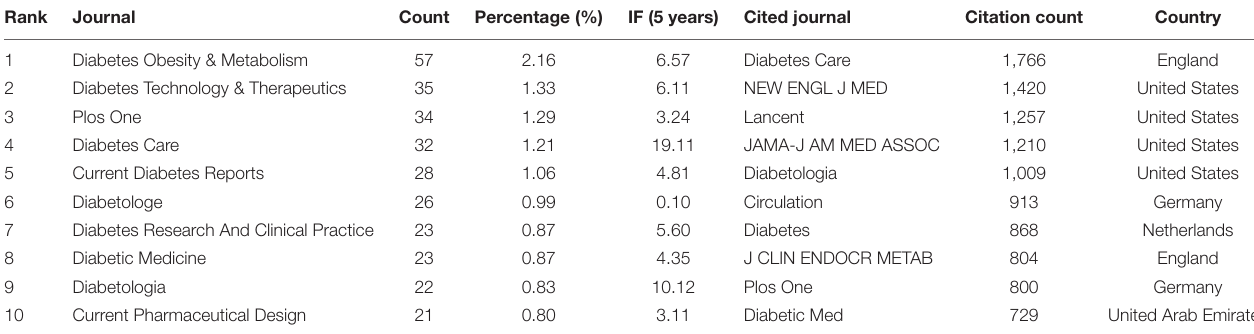
TABLE 4 | The top 10 prolific journals in physical activity therapy for diabetes research.